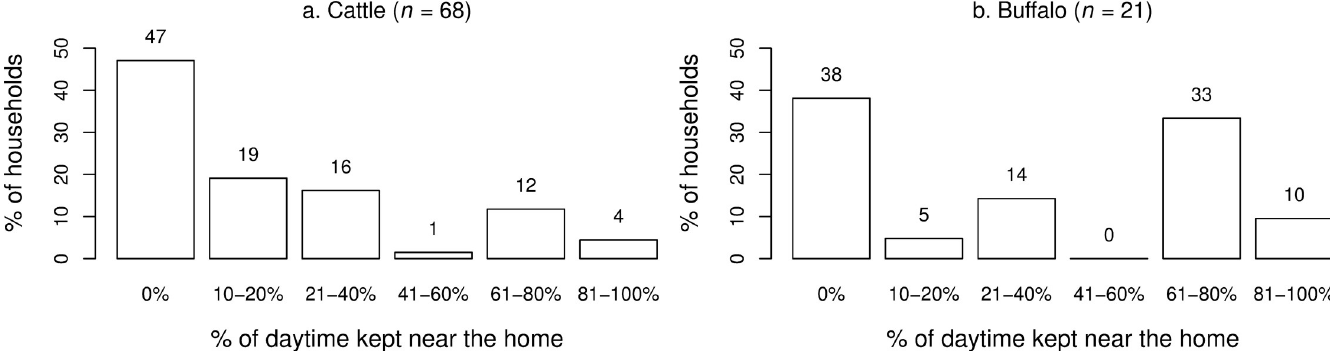
Fig 3. Proportions of smallholder households reporting the amount of daytime (%) that large ruminants were kept near the homestead in 2018, Lao PDR. (a) cattle (b)